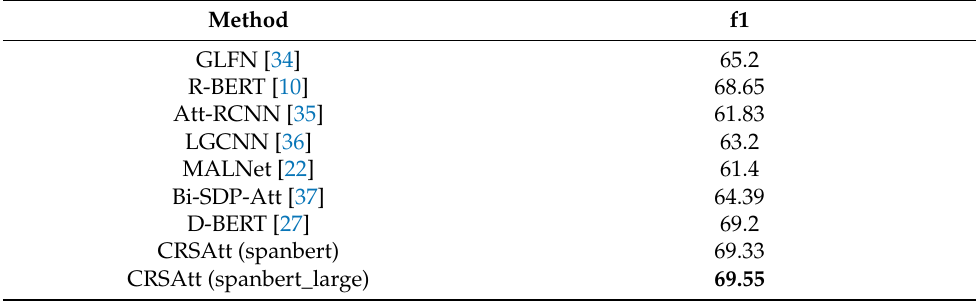
Table 9. Comparison of our model with existing methods on the KBP37